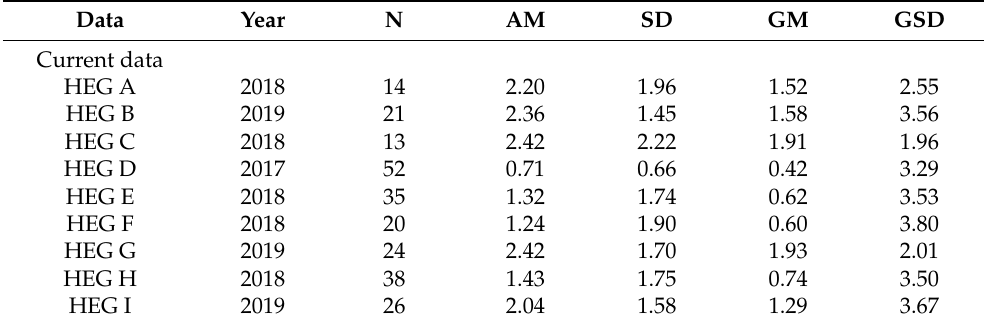
Table 2. Summary of coal dust exposure for the current monitoring data and their corresponding historical past